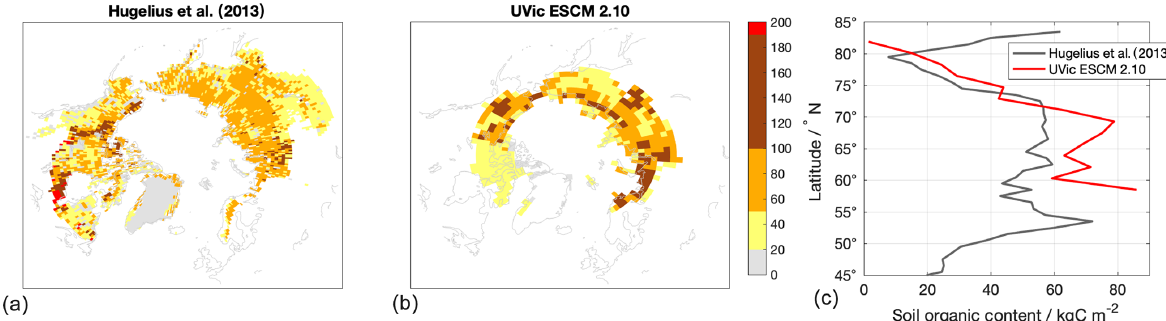
Figure 8. Soil organic carbon content in permafrost-affected soils for the 1980–2000 period in the top 3m of soil (in kgCm − 2 ) from the dataset by Hugelius et al. (2014) (a) and for the UVic ESCM 2.10 (b) . Zonally averaged values as a function of latitude (c)